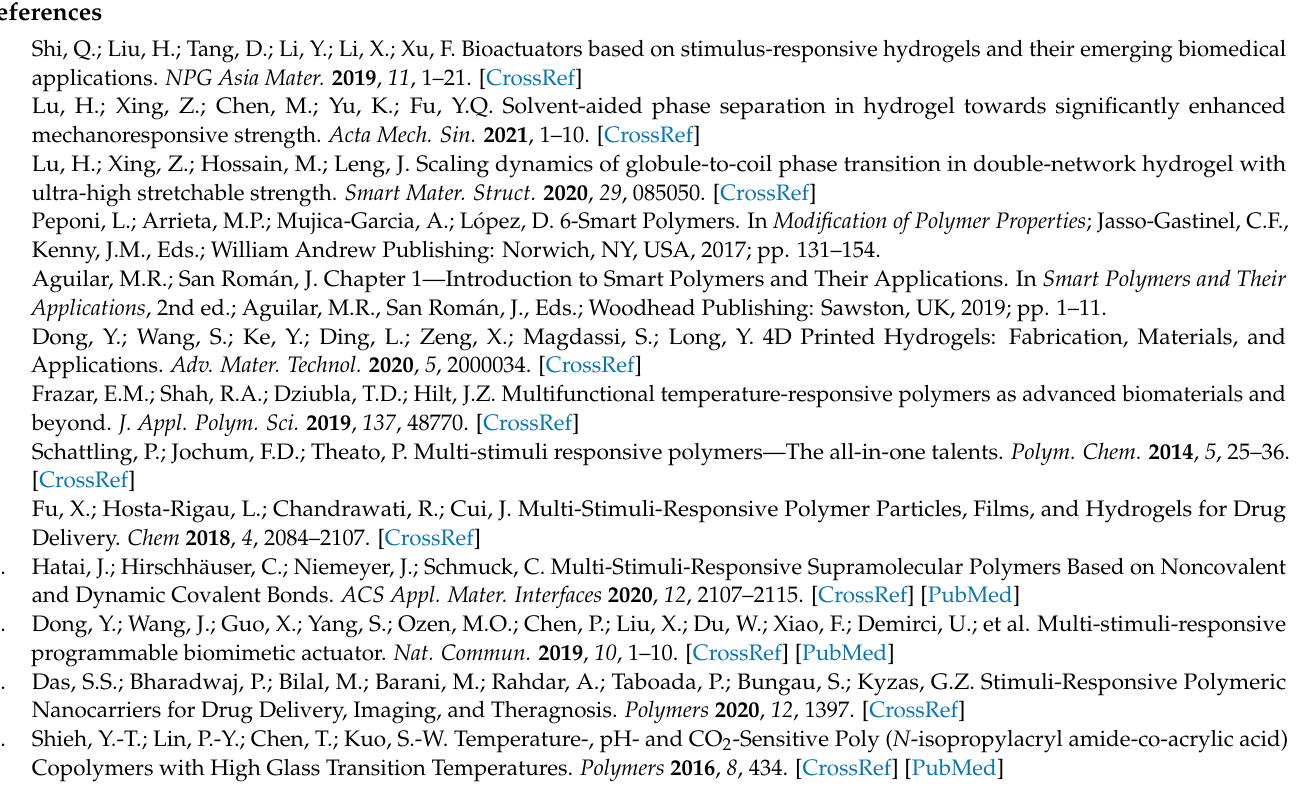
cesses, Figure S3: Intensity changes of the bands placed in two spectral regions (3010–2850 and Figure S4: Score plots of the first two PCs of P(NiPAAm- co -AAc) hydrogel at pH4, 3, and 2 during the heating and cooling